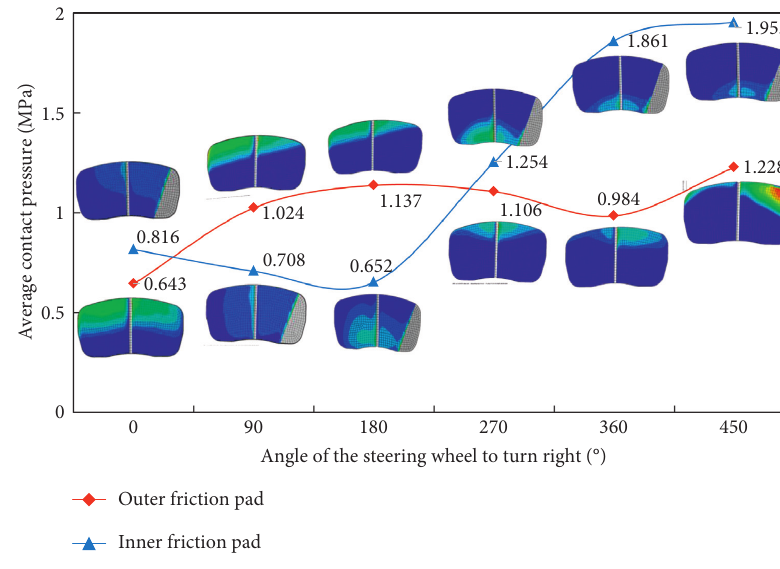
Figure 10: Interface pressure distribution between the pads and